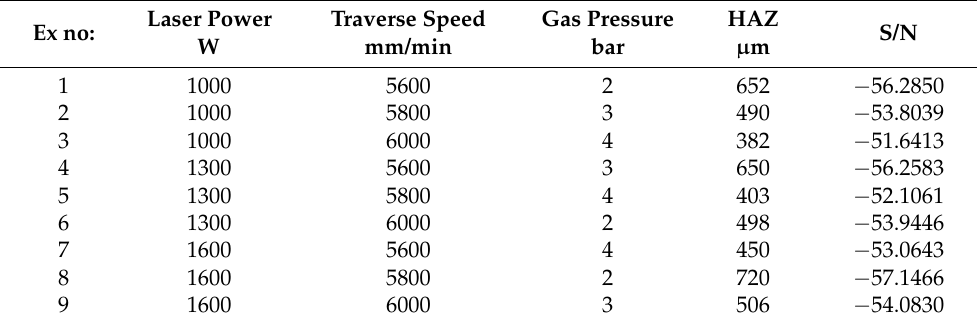
Table 7. L9 array of input parameter levels with measured HAZ and calculated S / N ratio according to Taguchi methods for 4 mm specimen thickness.